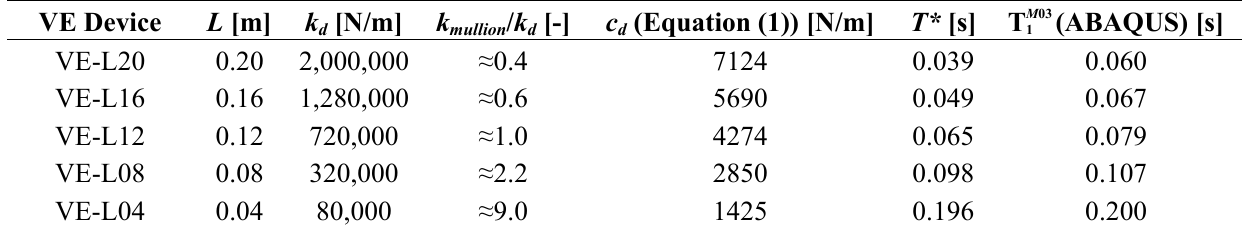
Table 2. Mechanical properties of VE devices ( h = 0.02